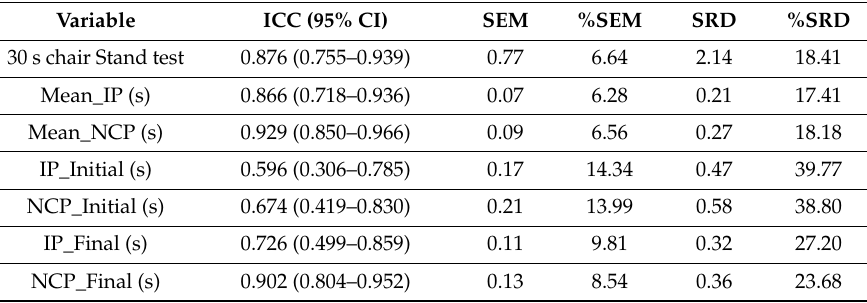
Table 4. Reliability of 30 s chair stand